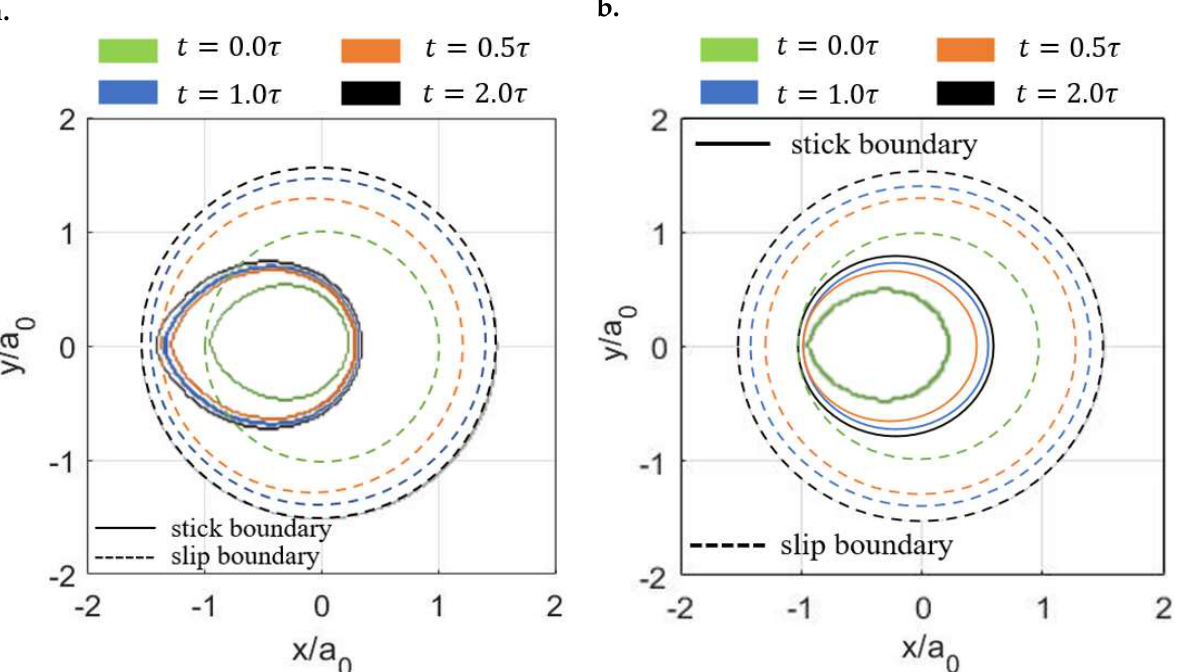
Figure 17. Separations of the stick and slip regions under constant inputs in x directions: ( a ) LC case and ( b ) DC case (the solid lines are the boundaries of the stick regions and the regions between the solid lines and dashed lines are the slip regions).